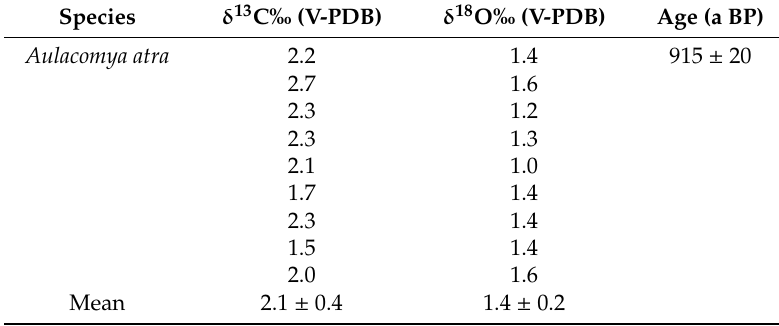
Table 3. Isotopic composition (oxygen and carbon) from samples from Holocene sections along the Camarones coastal area. For location see Figure